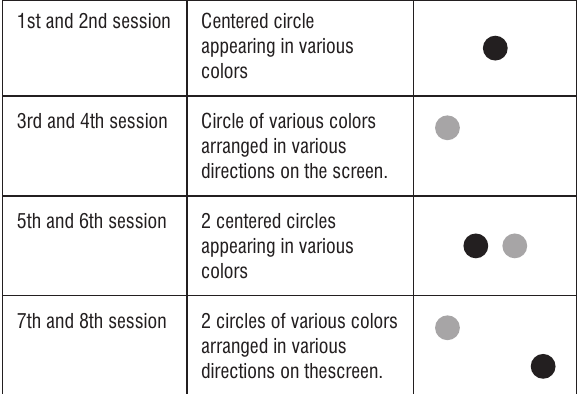
in Figure 1. The sequence of images started in the (cid:976)ifth minute after the start of the walk in electric tread- mill and the subject should verbalize the color of the circles that were appearing on the